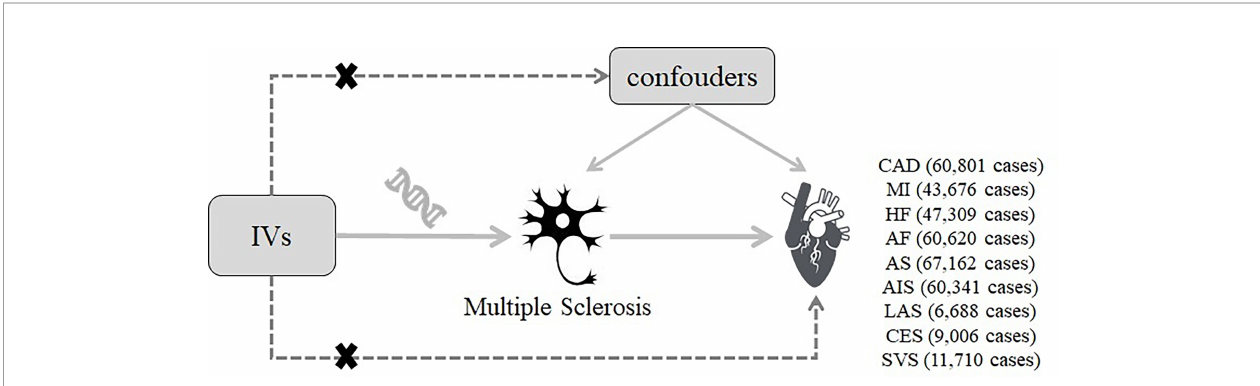
FIGURE 1 | Diagram of the two-sample Mendelian randomization study for the association between multiple sclerosis and the risk of cardiovascular diseases. IVs, instrumental variables; CAD, coronary artery disease; MI, myocardial infarction; HF, heart failure; AF, atrial fi brillation; AS, all-cause stroke; AIS, any ischemic stroke; LAS, large artery stroke; CES, cardioembolic stroke; SVS, small vessel